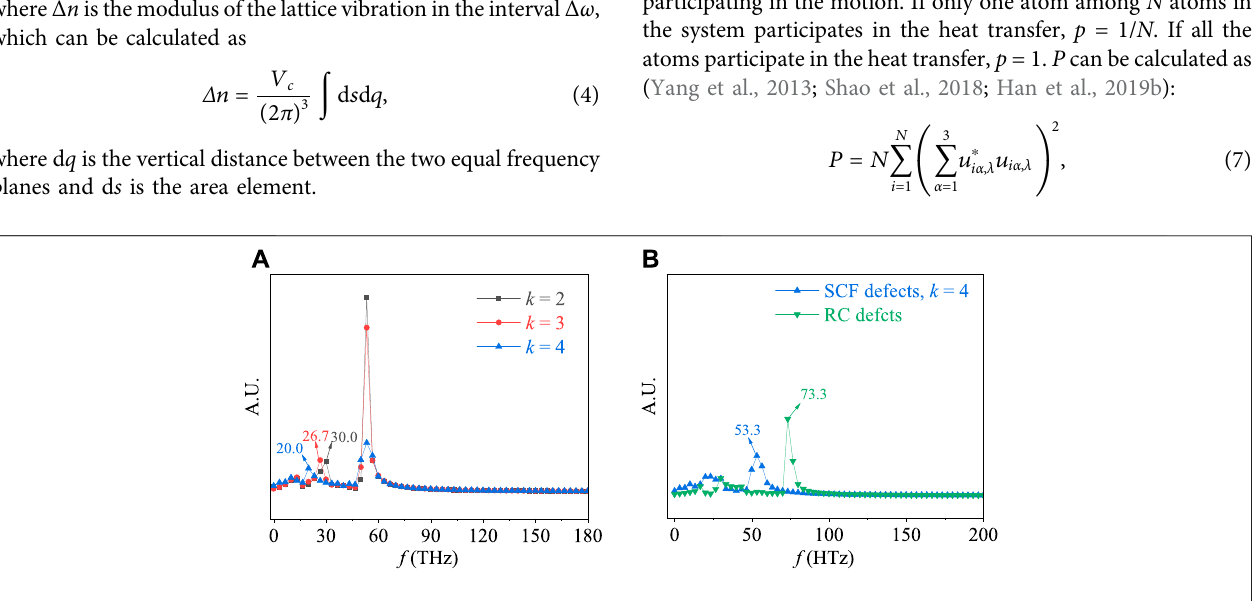
Frontiers in Energy Research |